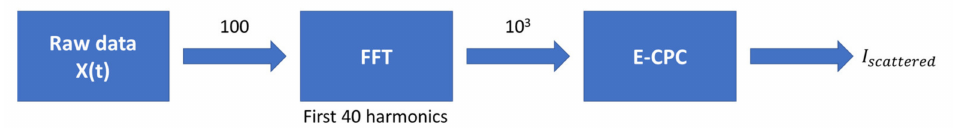
Figure 13. Illustration of multiplication factors in the quantity of data used in each